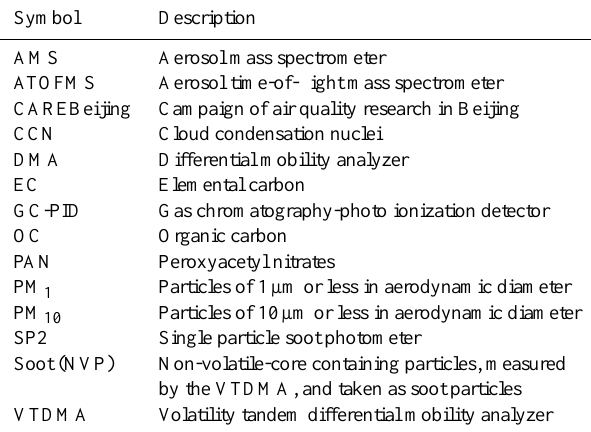
Table A1. Acronyms. Table A2.